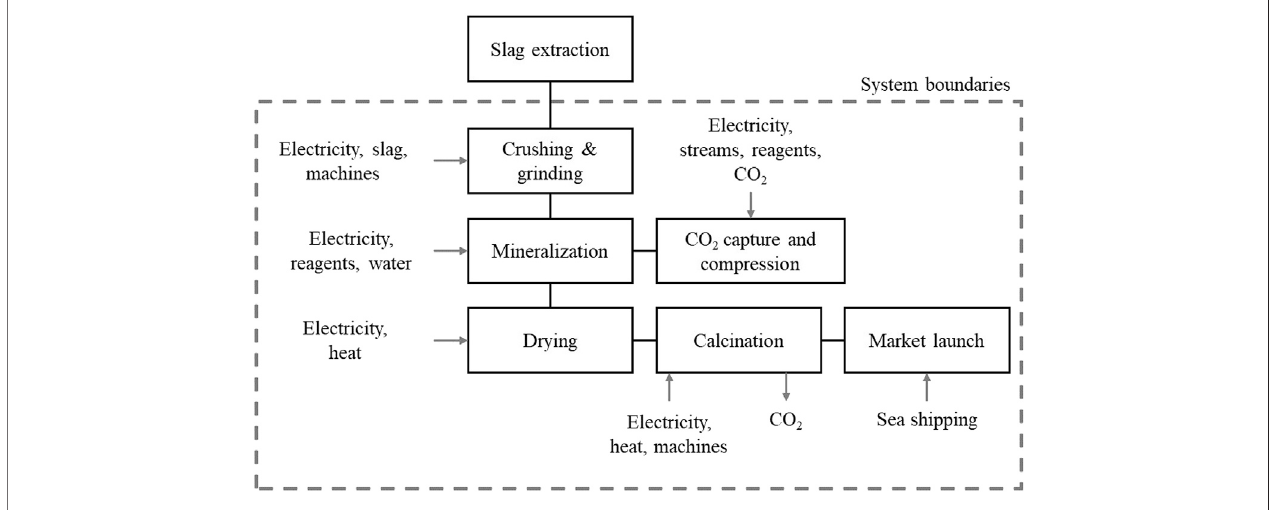
FIGURE 2 | The LCA system for the nickel slag valorization sector.